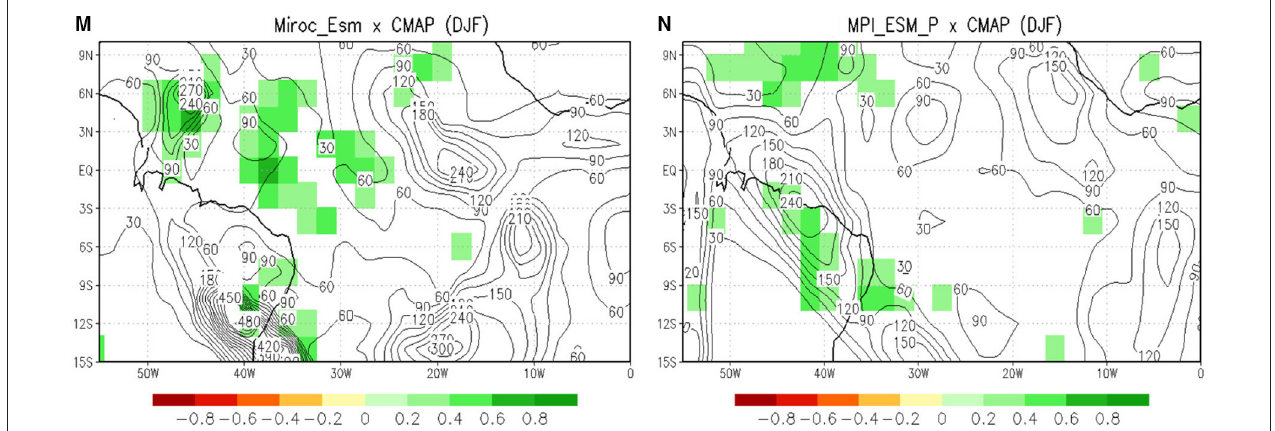
FIGURE 6 | Correlation (shaded) and absolute error (contour in mm/day) to summer (DJF) between observation (CMAP) and simulation from the CMIP5-AR5 models for period 1979–2000. Models considered are: (A) Access1_0, (B) Bcc_cms_1_1, (C) Bcc_ems_1_1, (D) Csiro_mk3_5, (E) Cesmi-Fastchem, (F) Cncrm_cm, (G) Ec_Earth, (H) Iap_Goals, (I) Fio_esm, (J) Gfdl_Esm2g, (K) Giss_e3_r_ce, (L) Hadgem2_ES, (M) Miroc_Esm, and (N) MPI_ESM_P. Green areas indicate statistical significance of the correlation at 95% according to the Student’s t